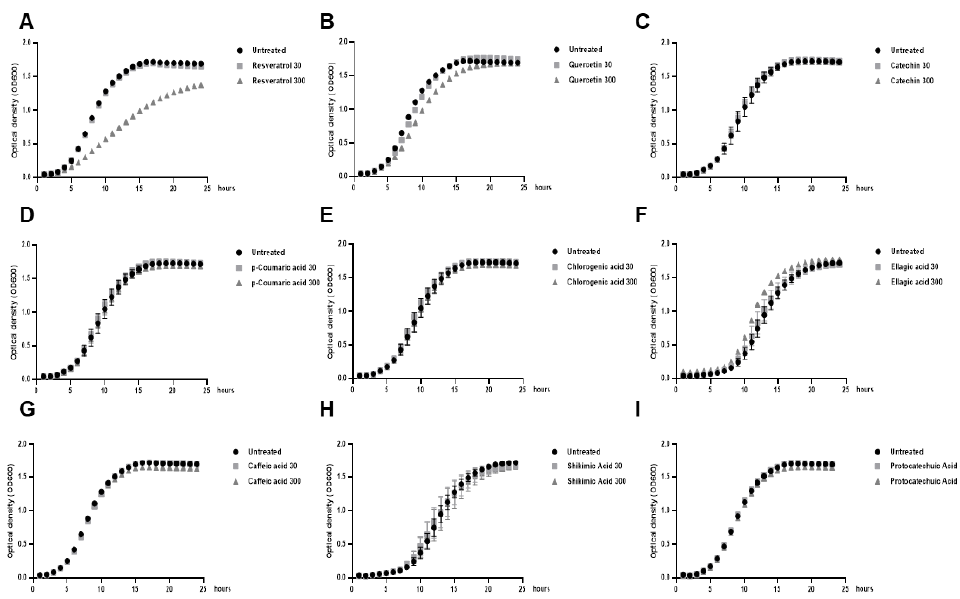
Figure A2. Growth curves of L. rhamnosus GG treated with various polyphenols. ( A–I ) Growth curves of L. rhamnosus GG untreated (black filled circle) or incubated with 30 µM (gray-filled square) or 300 µM (gray-filled triangle) of the indicated polyphenols in MRS medium at 37 °C. The OD 600 was monitored at 1 h intervals for 24 h. Values represent mean ± SEM of three separate experiments.